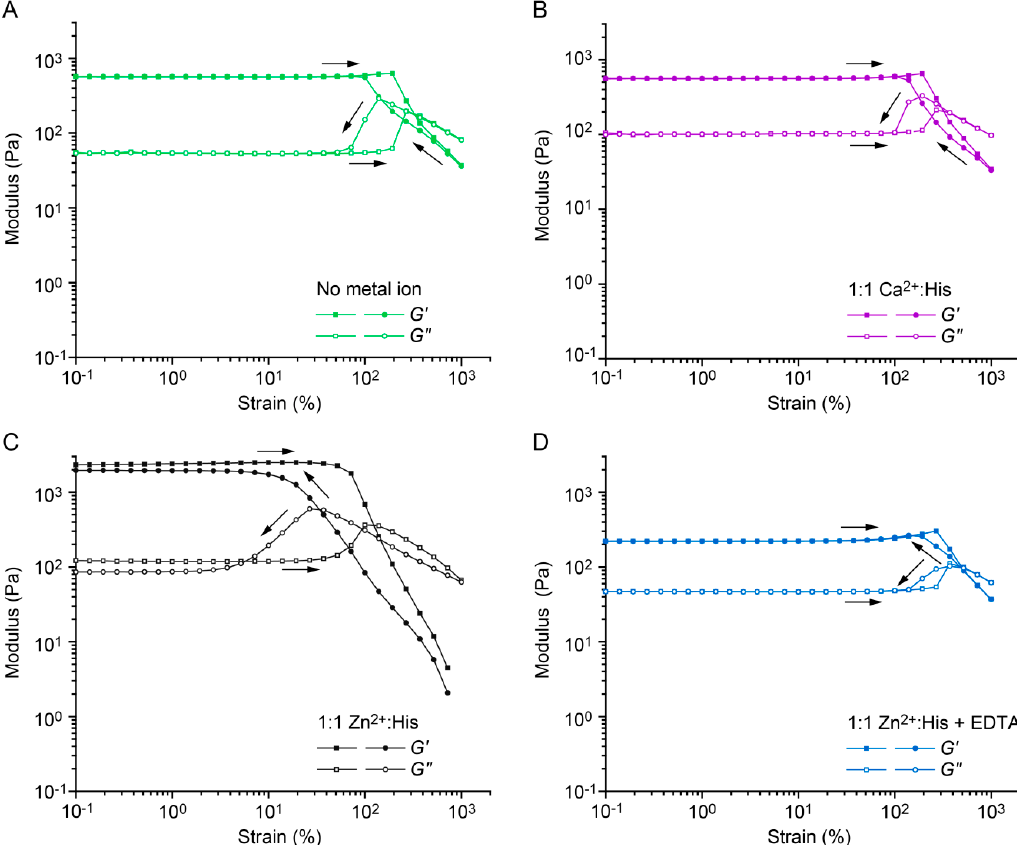
Figure 3. Amplitude sweeps of A 4H3 B 4H3 -containing hydrogels in PIPPS buffer. Amplitude sweeps were performed at a constant angular frequency of 10 rad s − 1 , changing the strain amplitude from 0.1% to 1000% and vice versa. ( A ) In the absence of metal ions; ( B ) in the presence of 1:1 Ca 2+ :His; ( C ) 1:1 Zn 2+ :His; ( D ) or 1:1 Zn 2+ :His + 25 mM EDTA (4 × excess with respect to the His concentration).